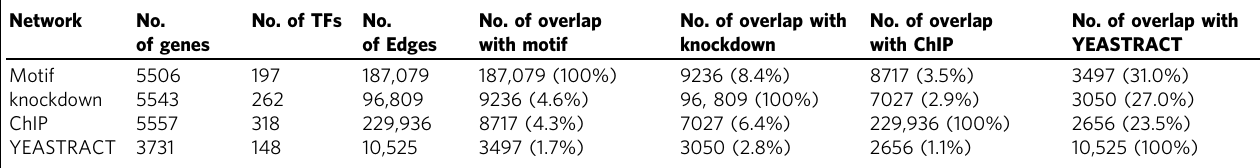
Table 1 Overlap between prior networks and the gold standard network. Network